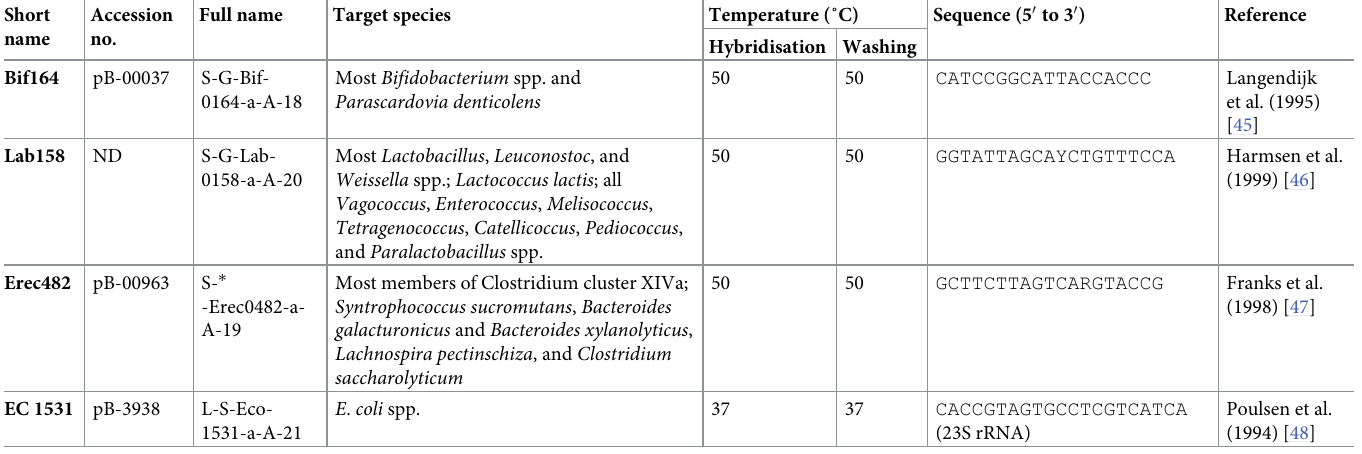
Table 1. FISH probes for bacterial population analysis in